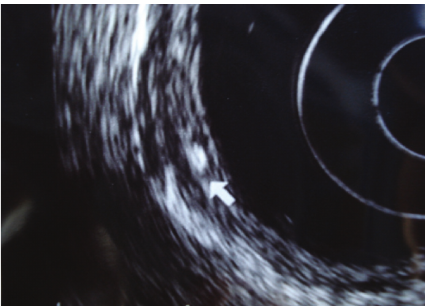
Figure 2: Endoscopic ultrasound image of a submucosal granuloma with calcified egg in its interior (white